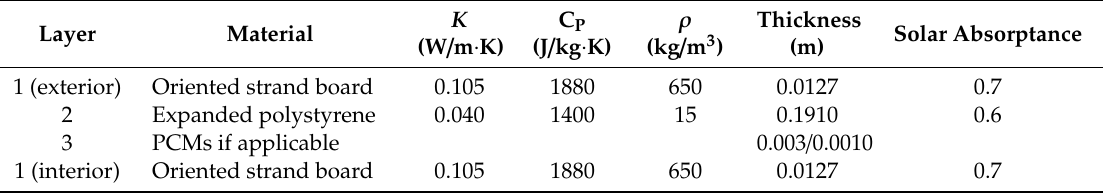
Table 2. Building materials for external wall construction. PCM: phase change